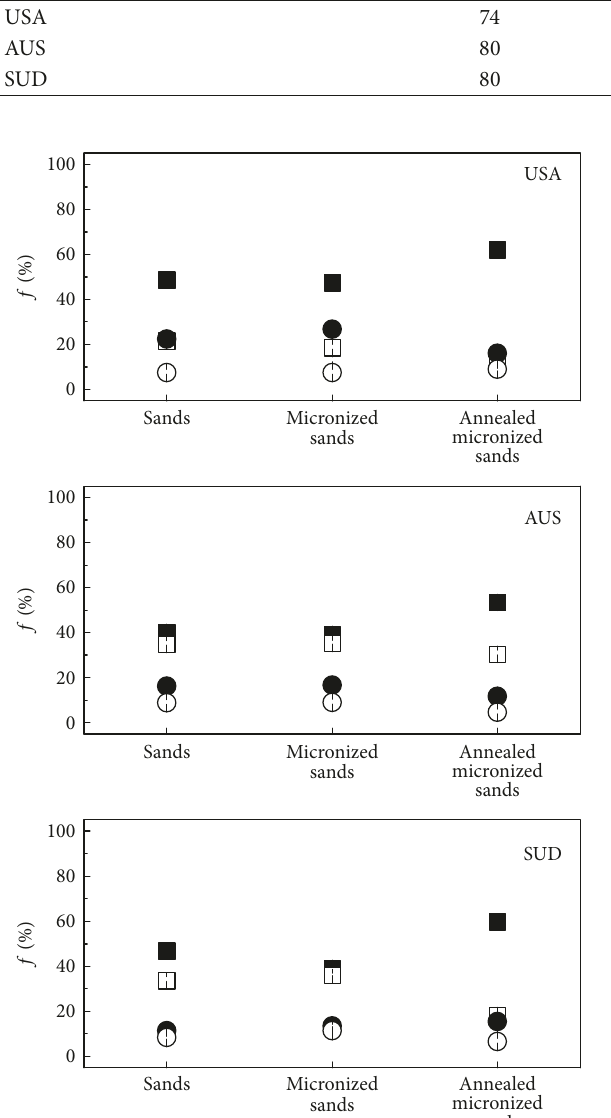
Figure 6: Relative abundances of the various surroundings of the PAC probe nuclei 𝑓 2 /(𝑓 2 + 𝑓 4 ) in the metamict state as a function of the bridge region